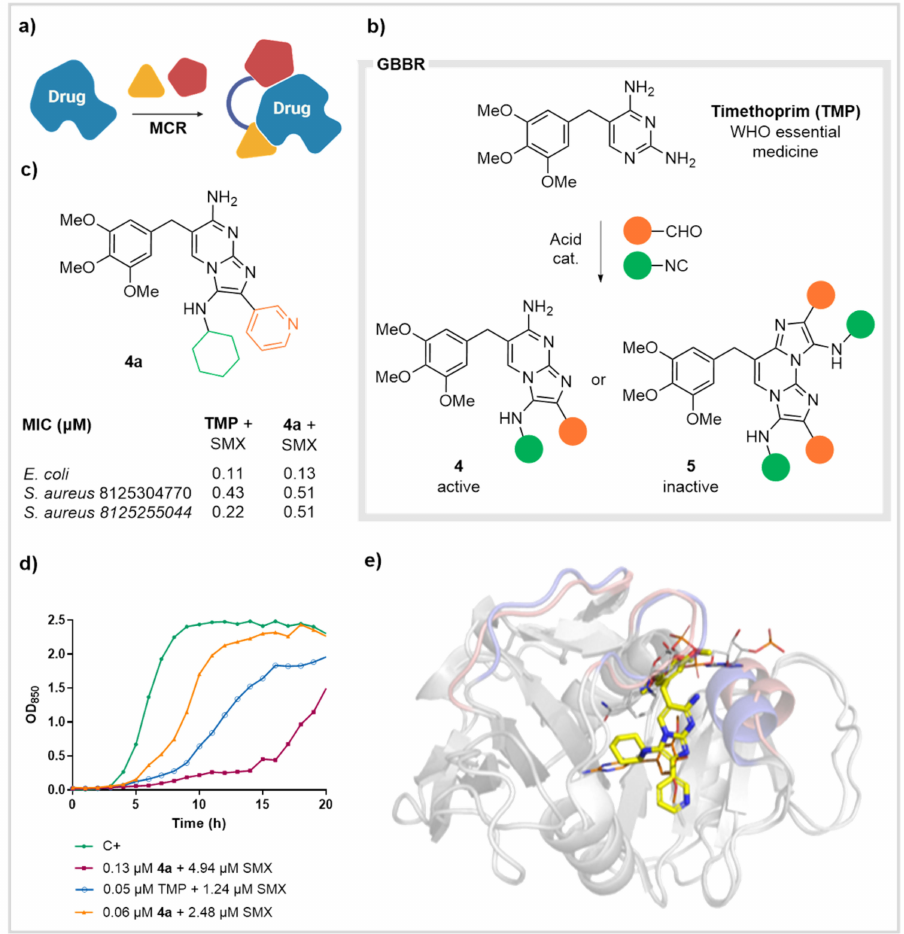
Figure 3. DHFR inhibitors. ( a ) Concept of the Drugs form Drugs approach. ( b ) Structure of trimetho- prim and GBBR leading to mono- and bis- adducts 4 and 5 , respectively. ( c ) Structure and activity data of lead compound 4a . ( d ) Growth curve of E. coli with TMP and 4a in combination with SMX. ( e ) Docked position of adduct 4a (yellow) in DHFR (homology model from E. coli ). The location of TMP (orange) and NADPH (gray) is also